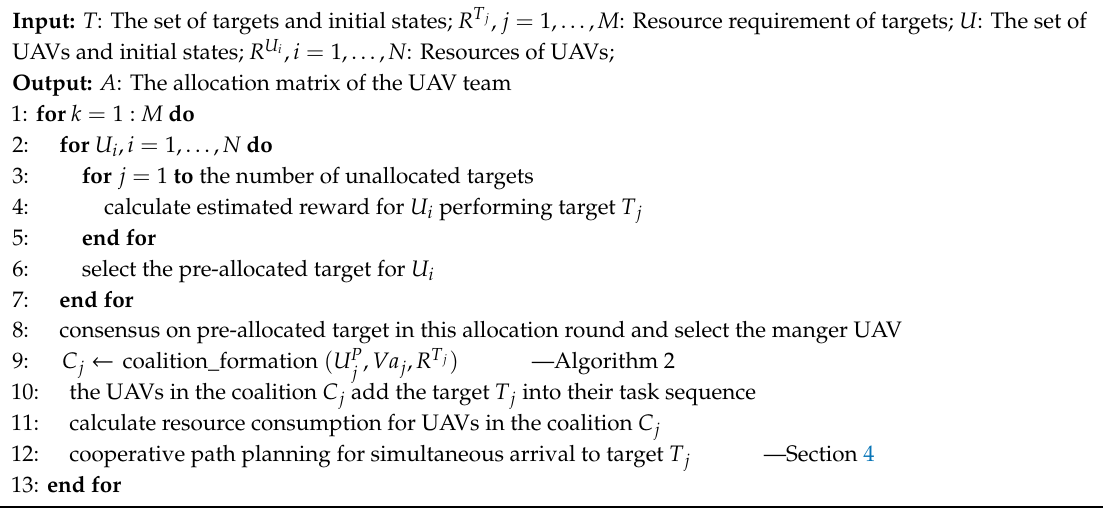
Algorithm 1. Task allocation algorithm